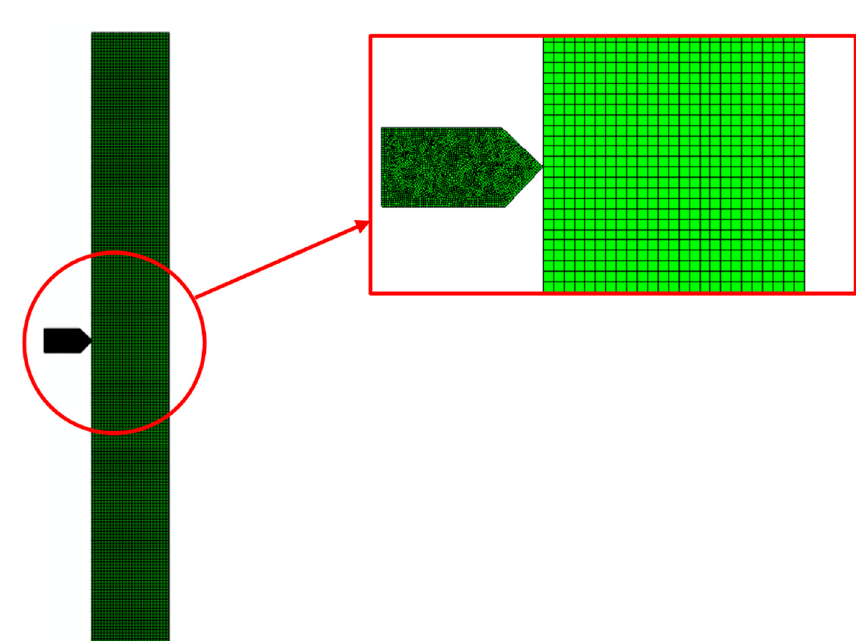
Figure 3. Assembly of Bullet and Plate.